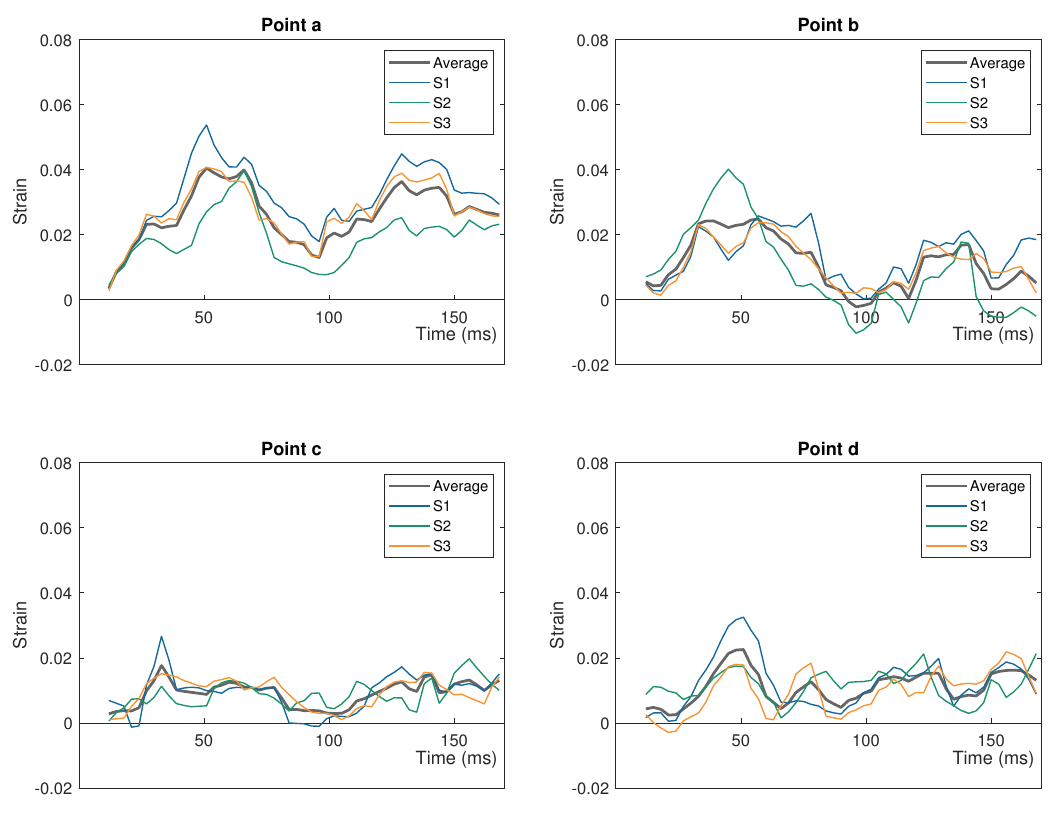
Figure 10. Principal strain magnitudes recorded during mild frontal impacts conducted by Feng et al. [54] at the same four discrete points as seen in Figure 9. The strains recorded from each subject, extracted from the original publication [54], are presented with a newly calculated group